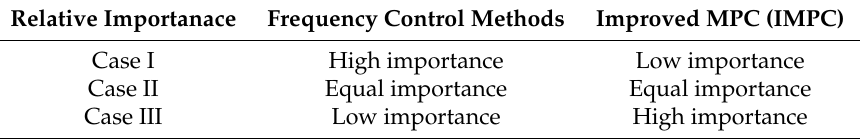
Figure 21. Weighting factors drifting based on the relative importance: average switching frequency and THDv of the V α for the three criteria; (black line) the derivative term is higher importance than the periodic term; (red line) the derivative term is lower importance than the periodic term; and (grey line) the derivative term is equal importance to the periodic term. ( a ) Average switching frequency for the three criteria; and ( b ) THDv of V α for the three criteria. Table 2. Relative Importance between